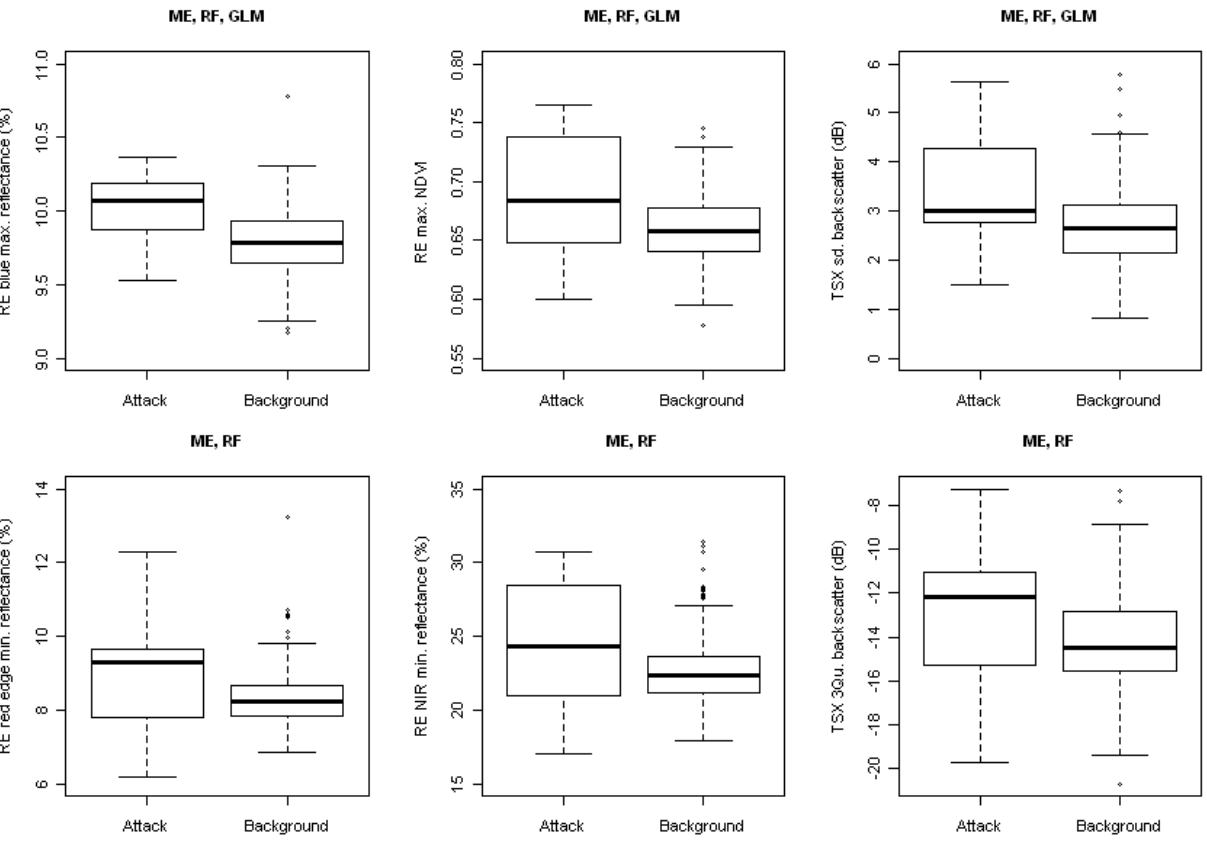
Figure 2. Boxplots of explanatory variables for the models with the highest classification accuracy. The individual figure captions indicate in which model type the explanatory variable is used (RE = RapidEye, TSX = TerraSAR-X, ME = maximum entropy, RF = random forest, GLM = generalized linear